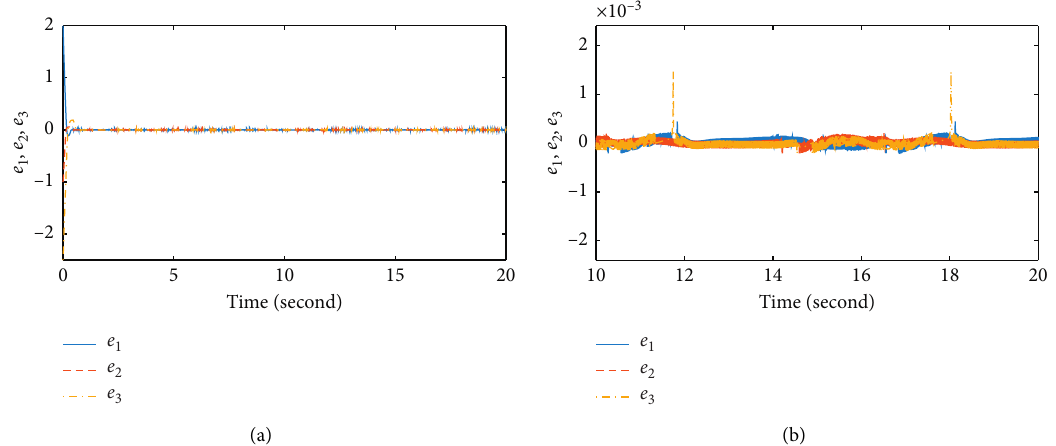
Figure 3: Case 2: the trajectories of tracking error e